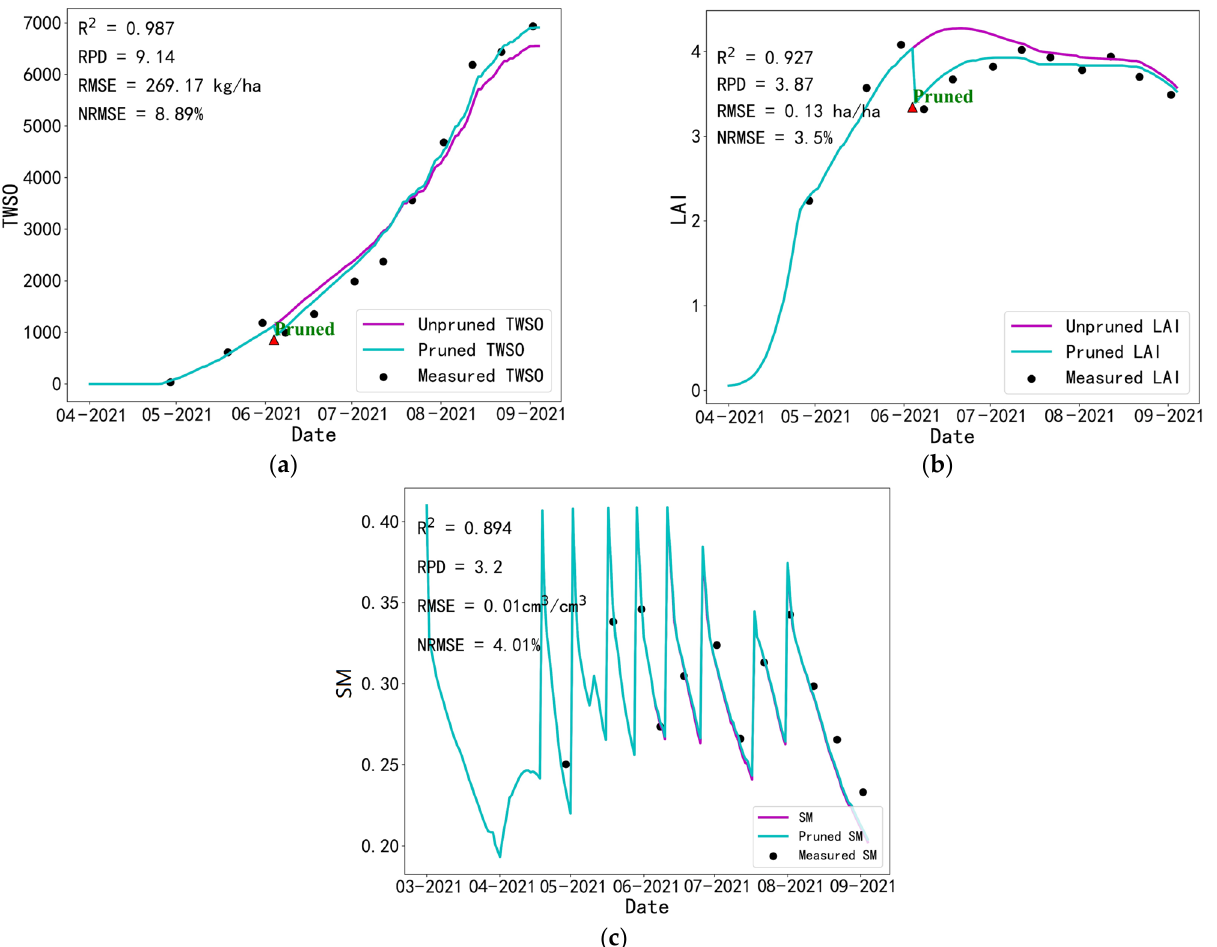
Figure 7. Simulated and measured TWSO ( a ), LAI ( b ) and SM ( c ) based on the modified WOFOST model.